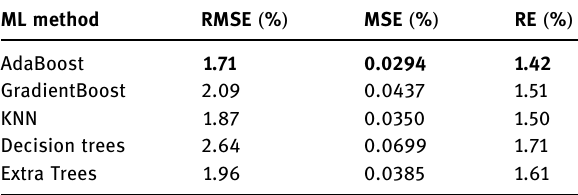
Bold values stand for the best performance in the